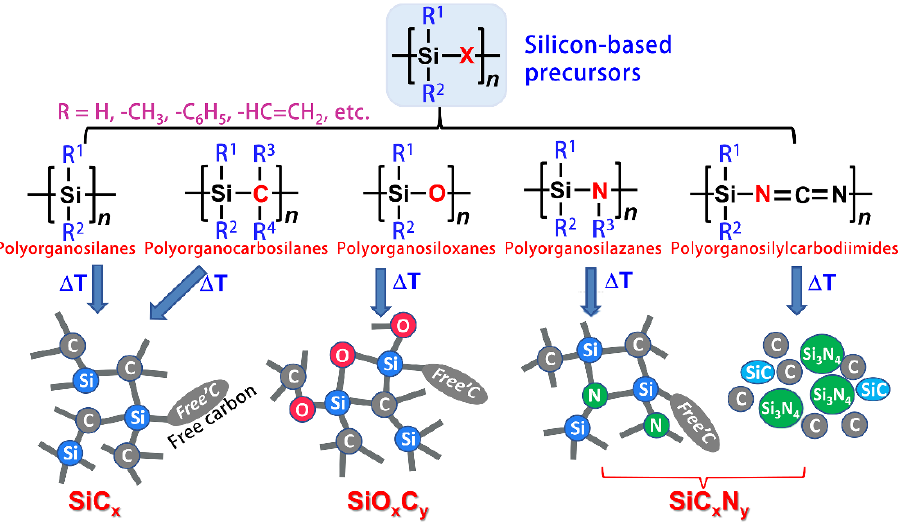
Figure 7. Silicon-containing preceramic polymers and resulting ceramics [67 – 69] .